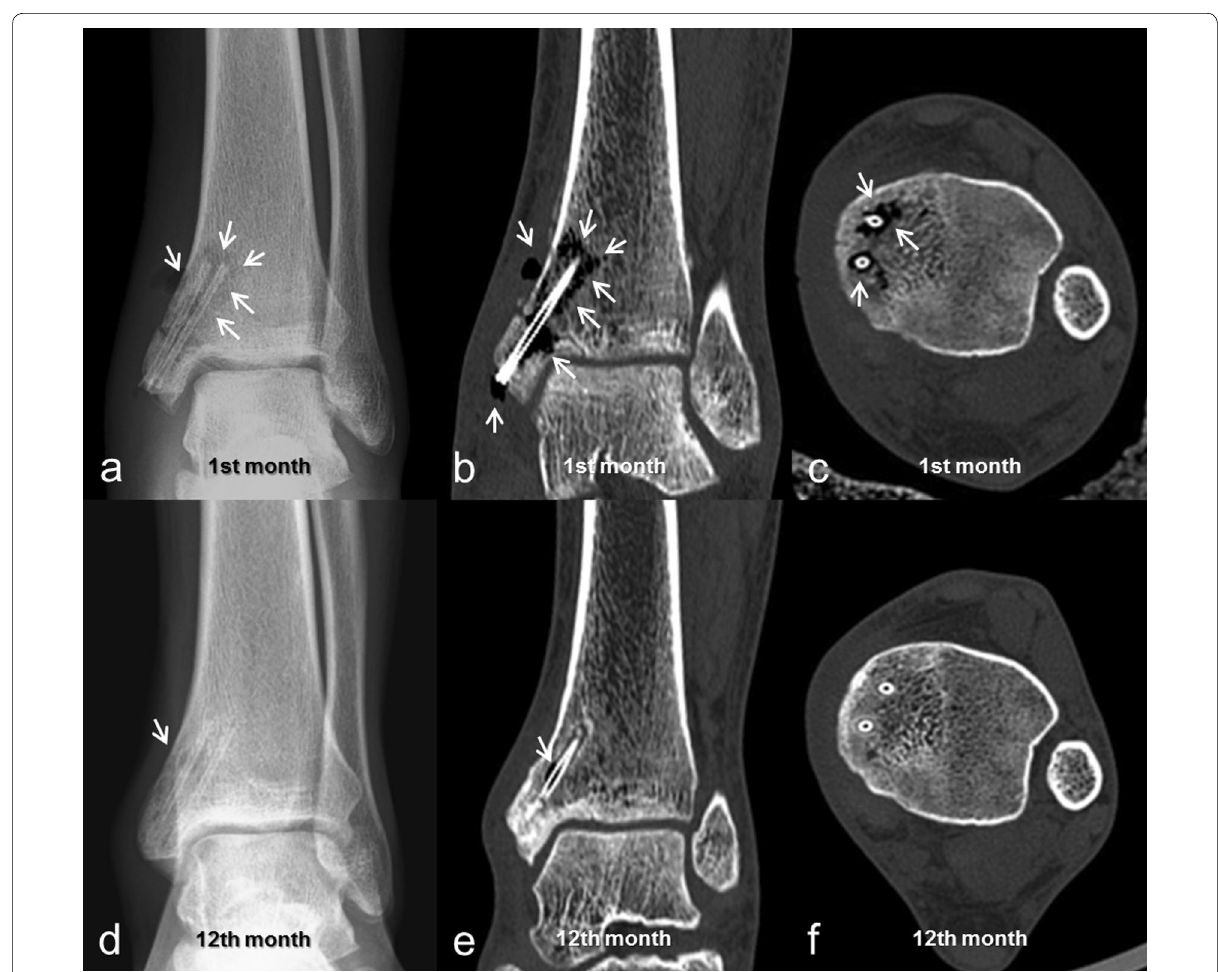
Fig. 3 a Early postoperative ankle radiograph of 21-year-old male patient with isolated medial malleolar fracture. Fracture fixed with two bioabsorbable Mg screws. Note gas both in soft tissue and around screws (white arrows); b Coronal and c axial CT taken at first-month follow-up showed gas formation around screws and scattered throughout cancellous bone (white arrows); d AP ankle radiograph at first-year follow-up, almost no gas accumulations were seen. d Coronal and e axial CT taken at first-year follow-up confirmed almost total absorption of released